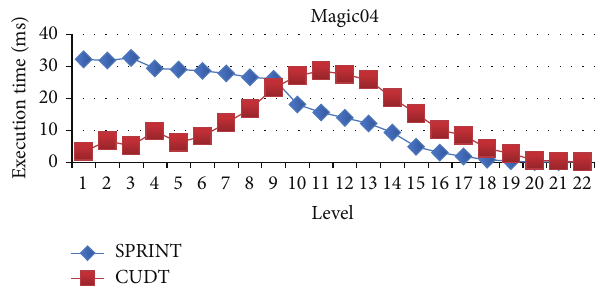
Figure 17: Execution time of each level on Magic04.